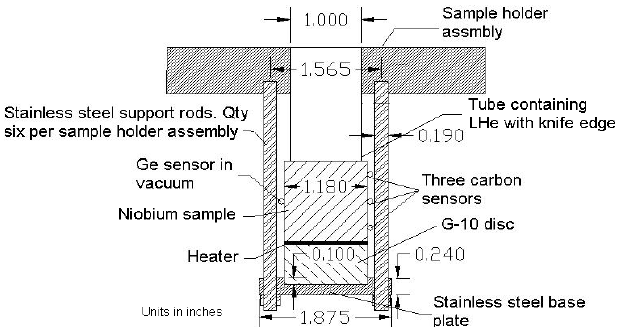
scale.FIG. 4. Cylindrical Nb sample experimental setup. The sample holder assembly has a Nb sample with a heater on the bottom side and a stainless steel tube with knife edge containing liquid helium on the other